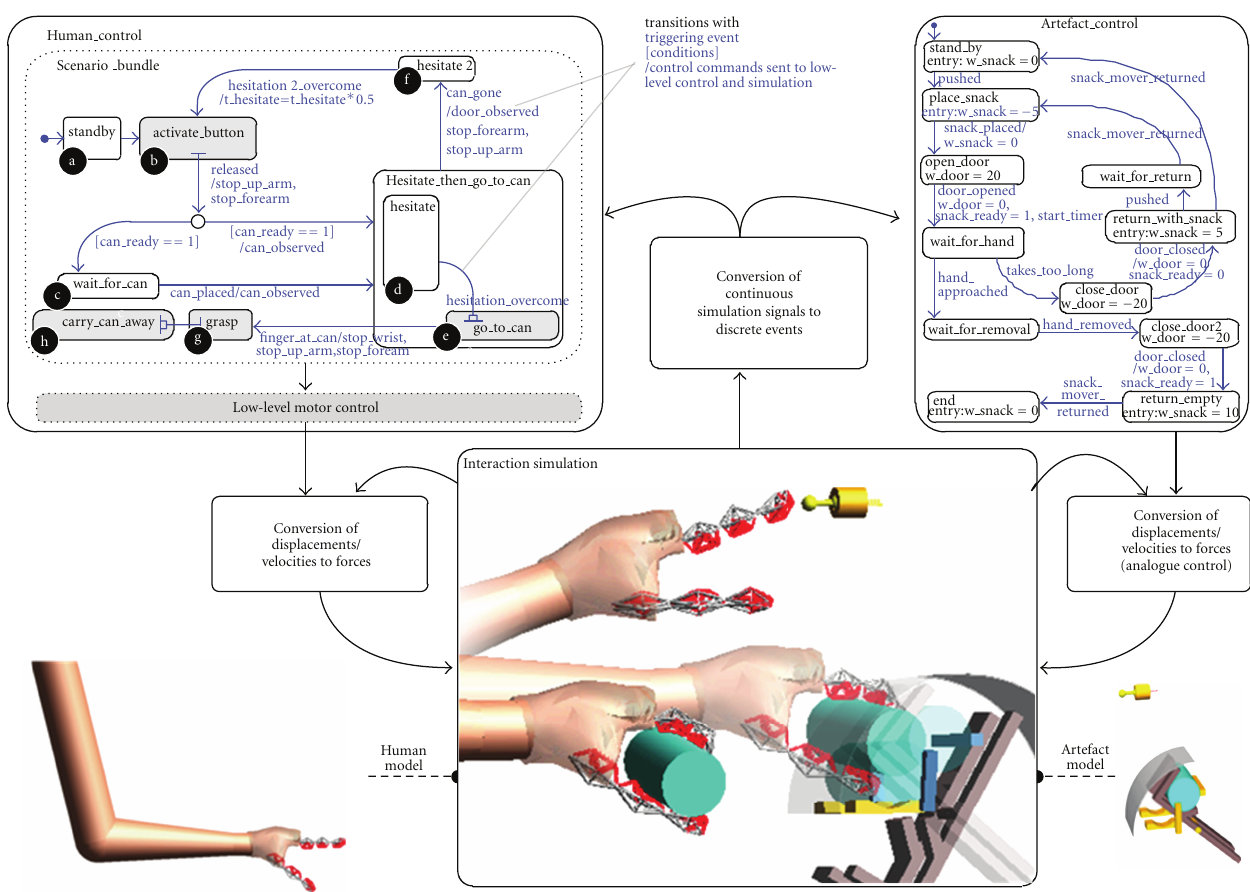
Figure 6: Simulation of human-artefact interaction based on scenario